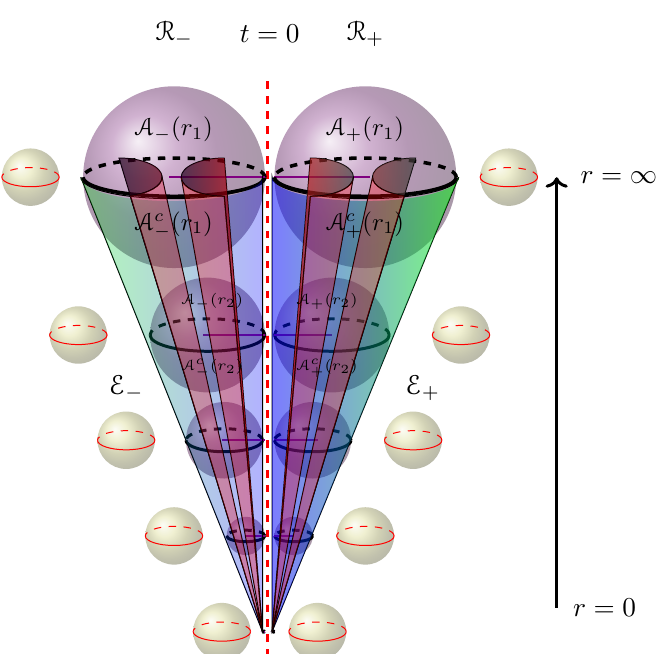
Figure 20 . The surgical split of the resolved conifold R = R (cid:0) [ R + when the con(cid:12)guration of interest contains Wilson lines. The Wilson lines uplift to Lagrangian cycles (indicated by the red surfaces) L R and L R if we consider the closed string dual of the density matrix prepared in i j (cid:12)gure 18. These cycles form an unknot in the S 3 , are stretched out along the radial direction of the cone, and wrap the equatorial S 1 (cid:26) S 2 (1). When we decompose the S 3 into B (cid:6) , these (cid:0) (cid:1) Lagrangian cycles are decomposed into L R = I (cid:6) (cid:2) R 2 and split endpoints lie on (cid:0) (cid:6) as we have R tried to